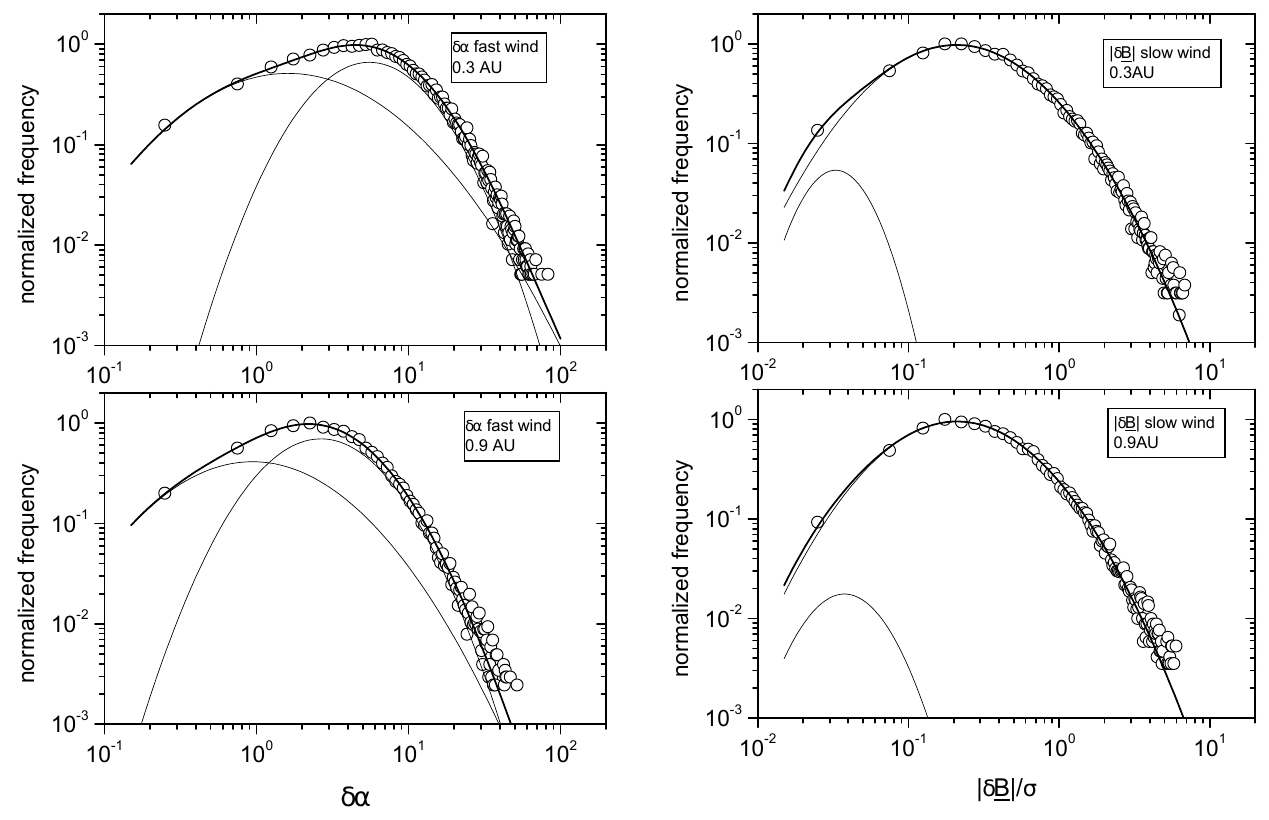
Fig. 9. PDFs of angular displacements δα at 0.3 and 0.9AU, for a fast wind, are shown in the top and bottom panels, respectively. The two thin solid curves refer to as many lognormals contributing to form the thick solid curve which best fit the distribution. Parameters relative to the fit are reported in Table 3.